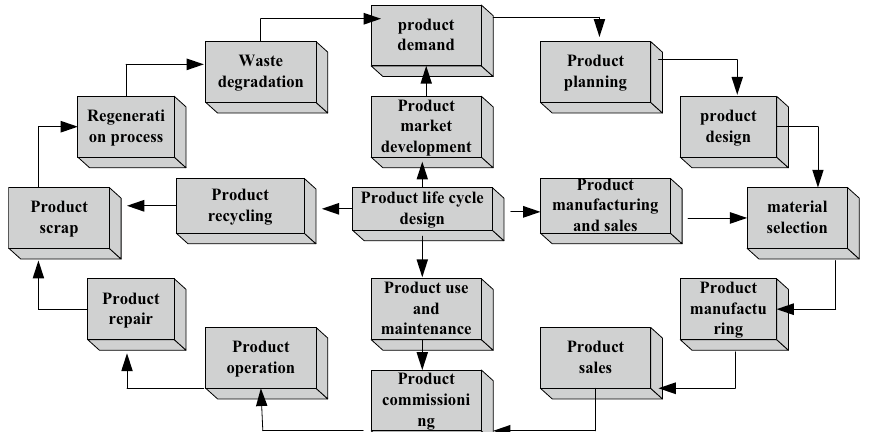
Fig. 4 Product life cycle